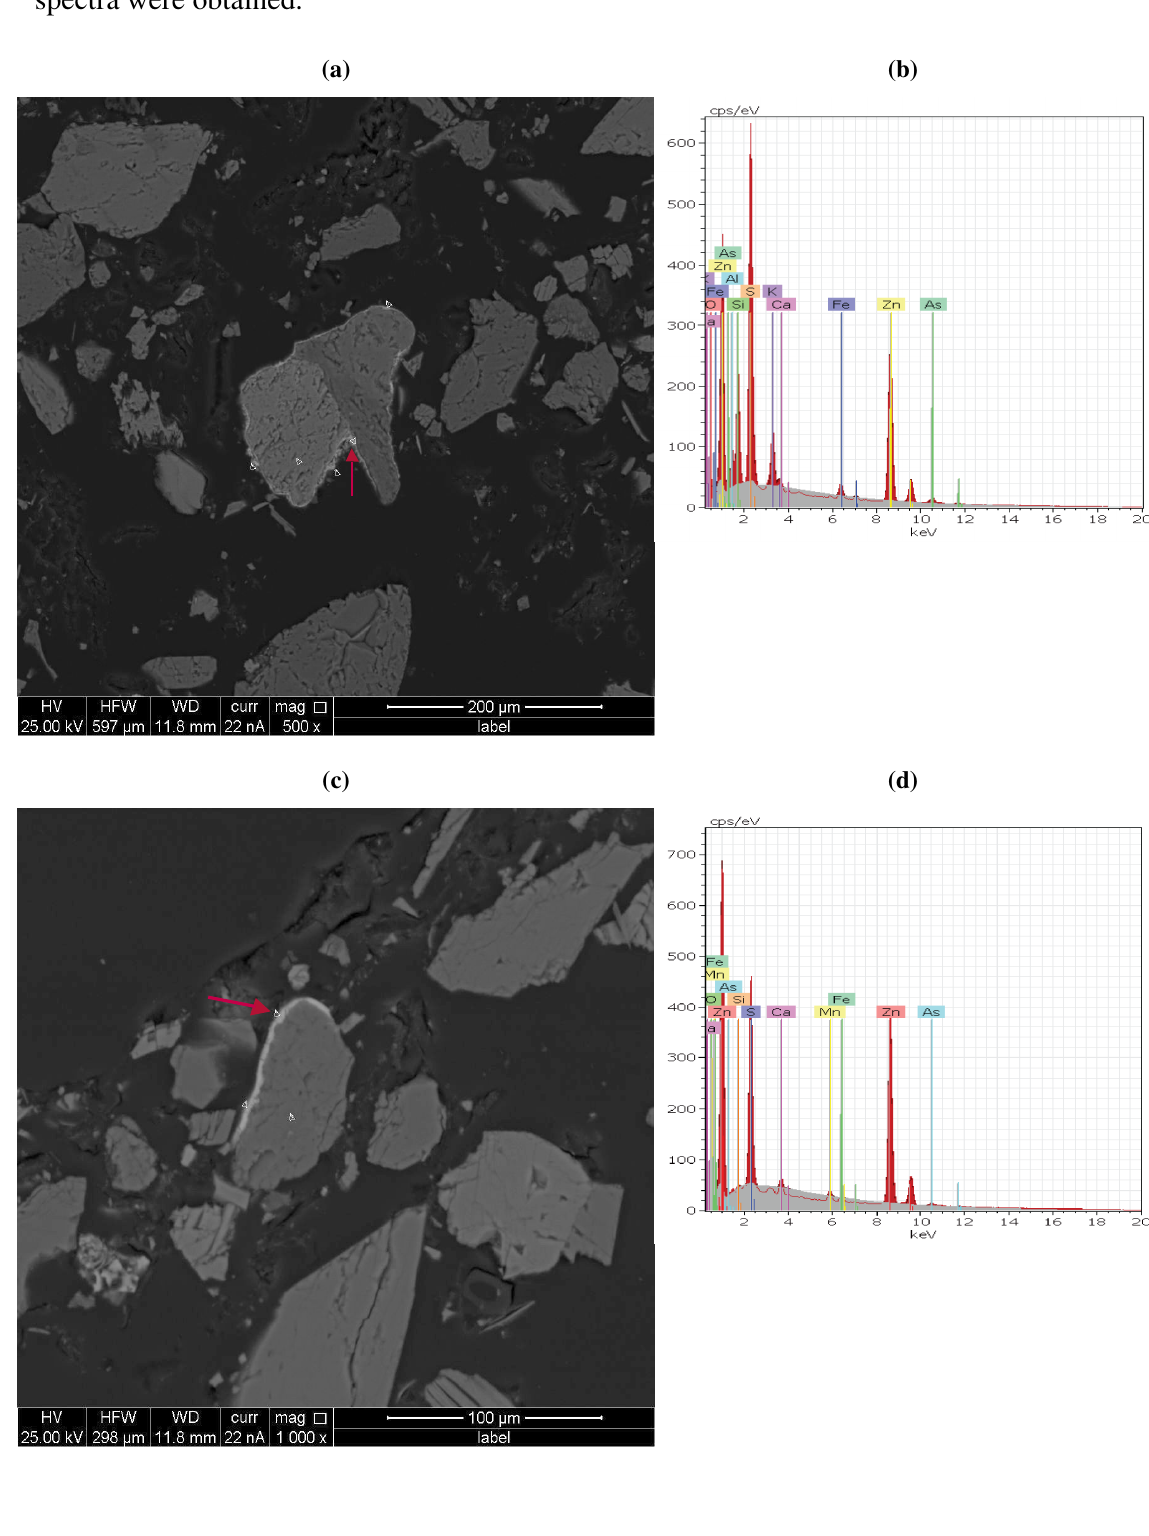
Figure 2. Backscattered electron microscopy photomicrographs of zinc-arsenic sulphides on the surface of ( a ) amphibole and ( c ) feldspar and one example EDX spectrum (( b ) and ( d )) from the bright mineral phase around the outside of the amphibole or feldspar (red arrow on the photomicrographs). The small white-boarded triangles indicate the positions where EDX spectra were